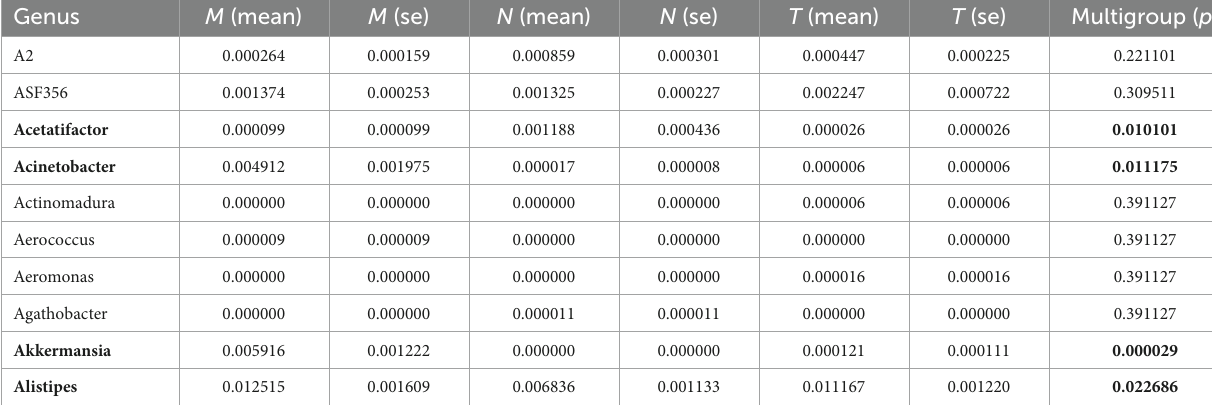
TABLE 1 ANOVA (analysis of variance) at genus level of bacterial